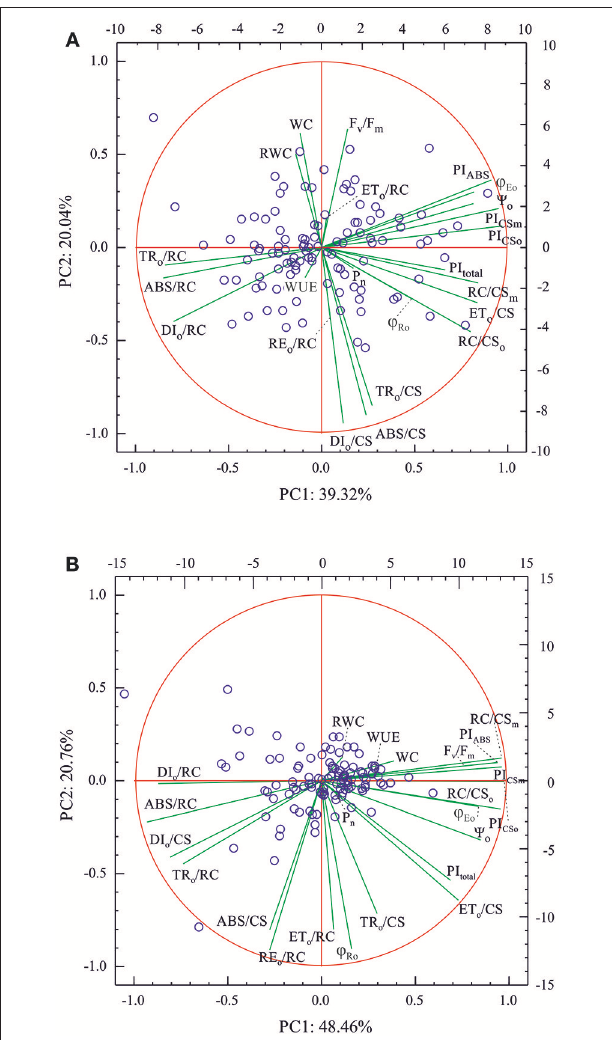
FIGURE 1 | Biplots of principal component analysis (PCA) for OJIP parameters, leaf water relations (WC, RWC), WUE and P N (variables) measured in 109 barley accessions (cases) in (A) well-watering conditions (control) and (B) in drought. Left y and bottom x axes refer to variables and right y and top x axes for the cases,